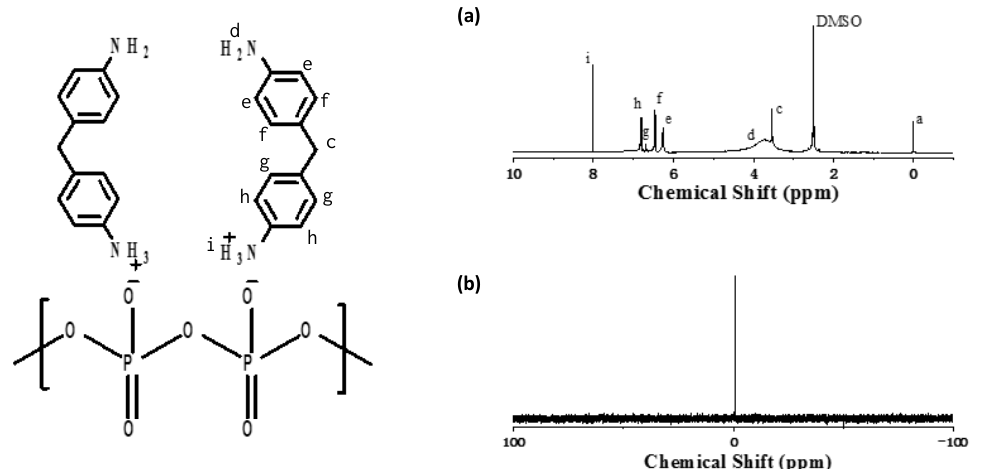
Figure 3. 1 H NMR ( a ) and 31 P NMR ( b ) spectra of